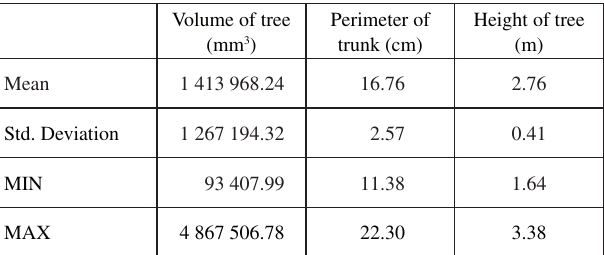
Table 1. The used parameters from point cloud and wrap data Volume of tree Perimeter of Height of tree (mm 3 ) trunk (cm) (m) Mean 1 413 968.24 16.76 Std. Deviation 1 267